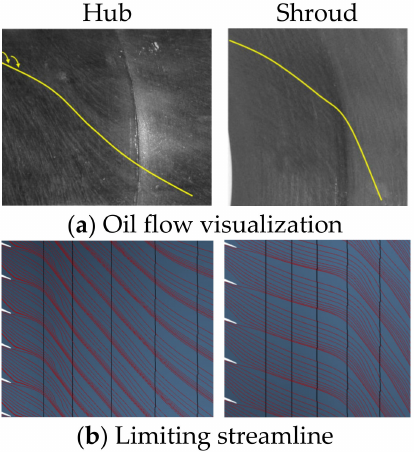
Figure 6. Flow visualization and computed limiting streamline on the